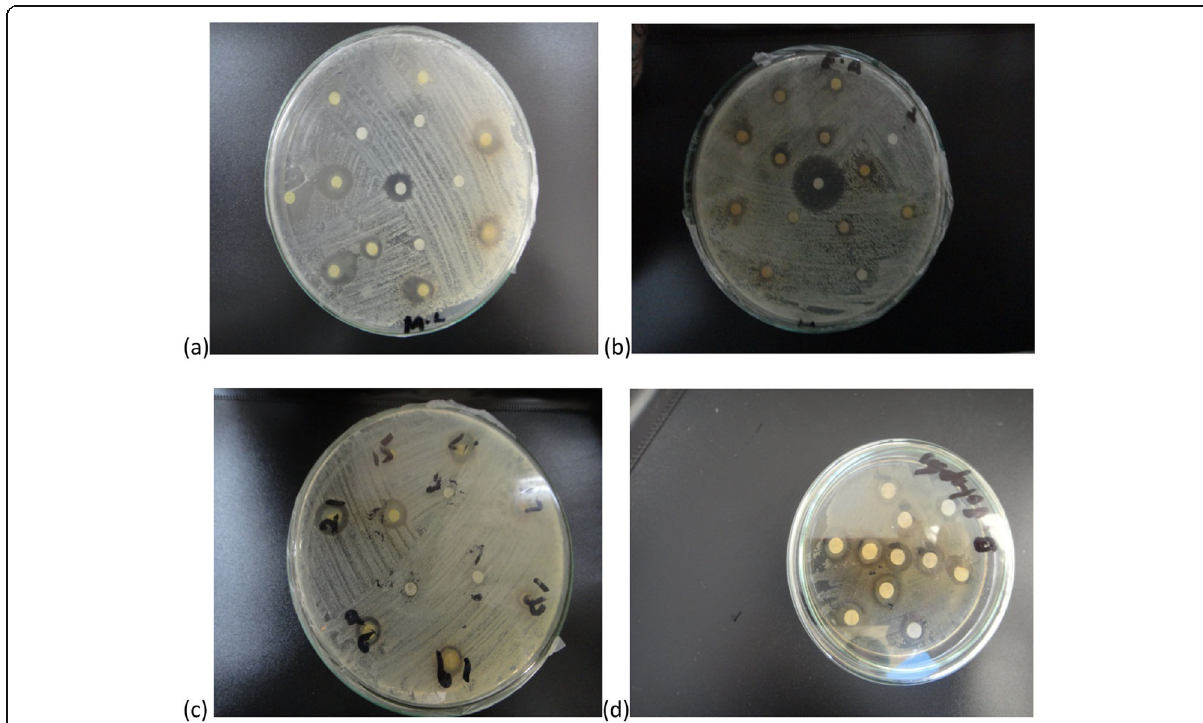
Fig. 5 Antibacterial activity images of A. jacquemontii extracts against a M. lutus b E. aerogens c S. aureus d B.